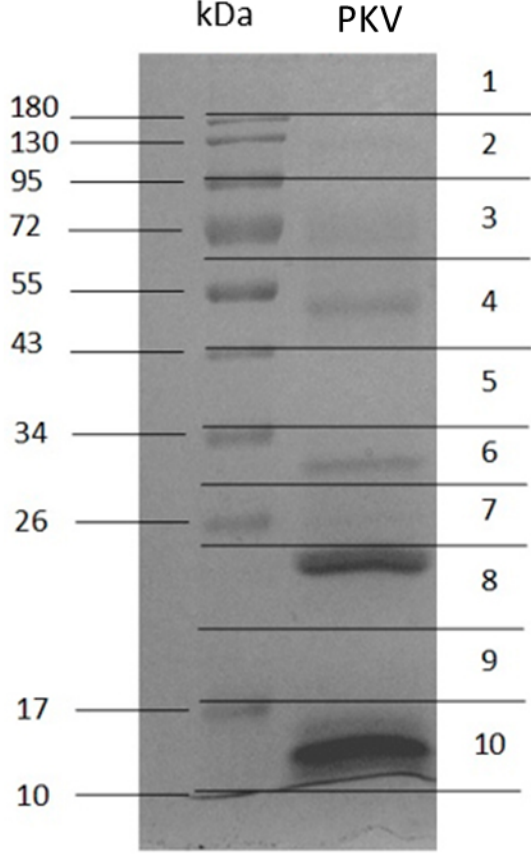
Figure 4. Protein separation of Protobothrops kelomohy venom on Coomassie blue-stained 12% gel electrophoresis under reducing